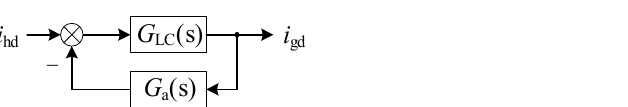
Figure 8. Closed-loop control structure of the d axis grid current. Q axis grid current has the same control structure. The dq axis coupling terms are ignored.